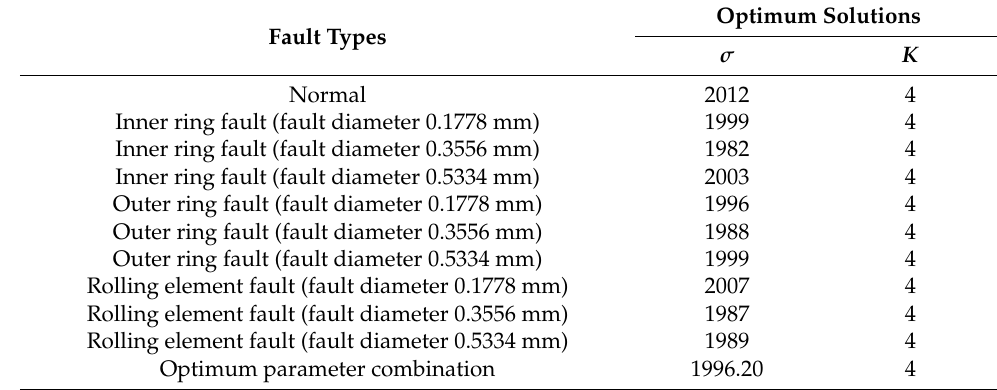
Table 2. Optimal parameter solutions.